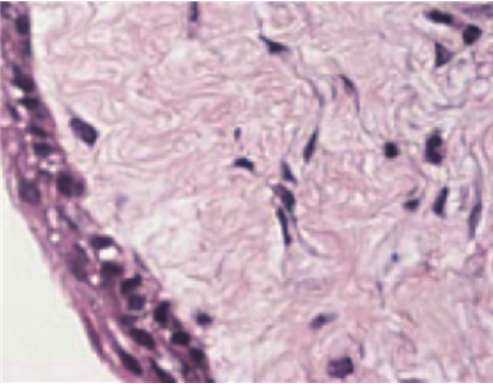
Figure 12: Histological